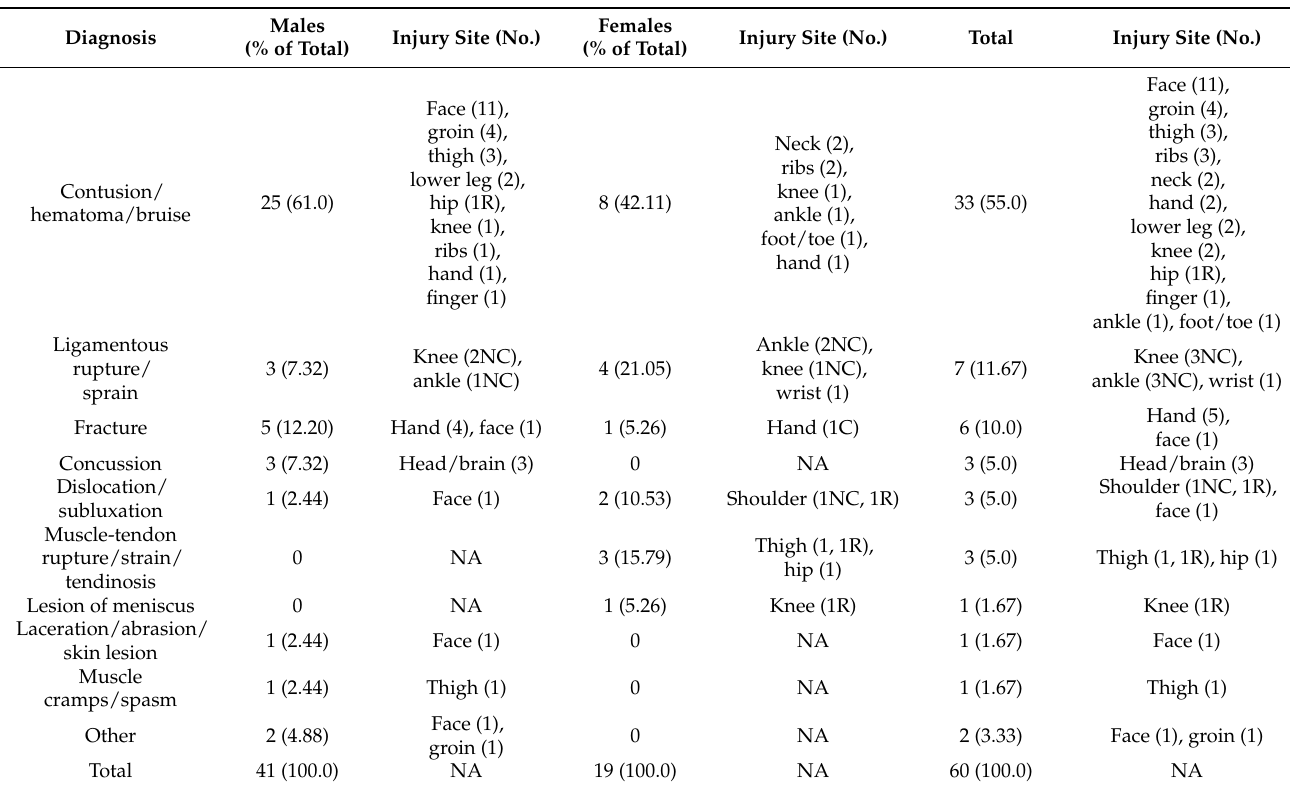
Table 2. Diagnosis by Injury Site at the 2019 World Taekwondo Championships in Manchester, United